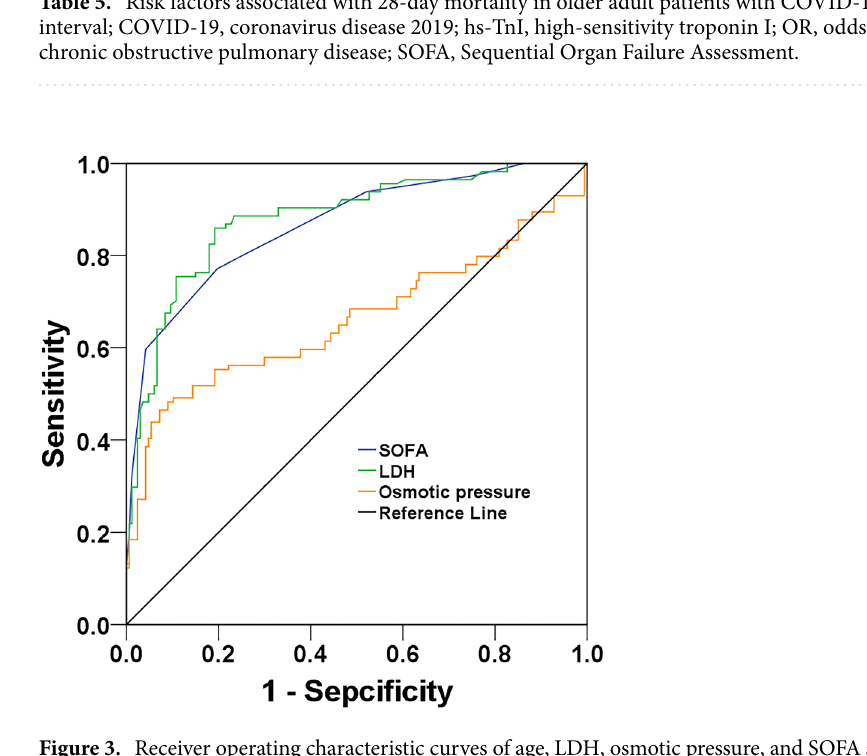
Figure 3. Receiver operating characteristic curves of age, LDH, osmotic pressure, and SOFA score for predicting 28-day mortality. LDH, lactate dehydrogenase; SOFA, sequential organ failure assessment.